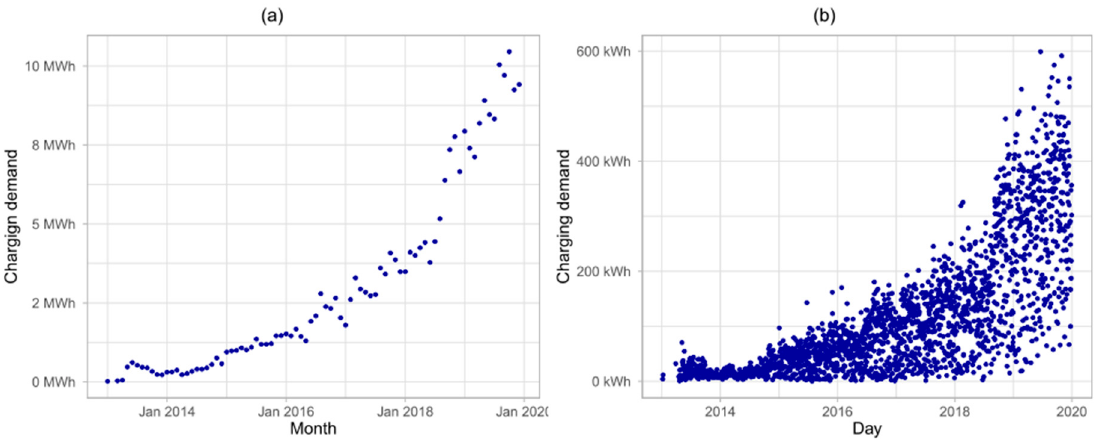
Figure 1. ( a ) Charging demand in all stations each month, ( b ) Charging demand in all stations each day.